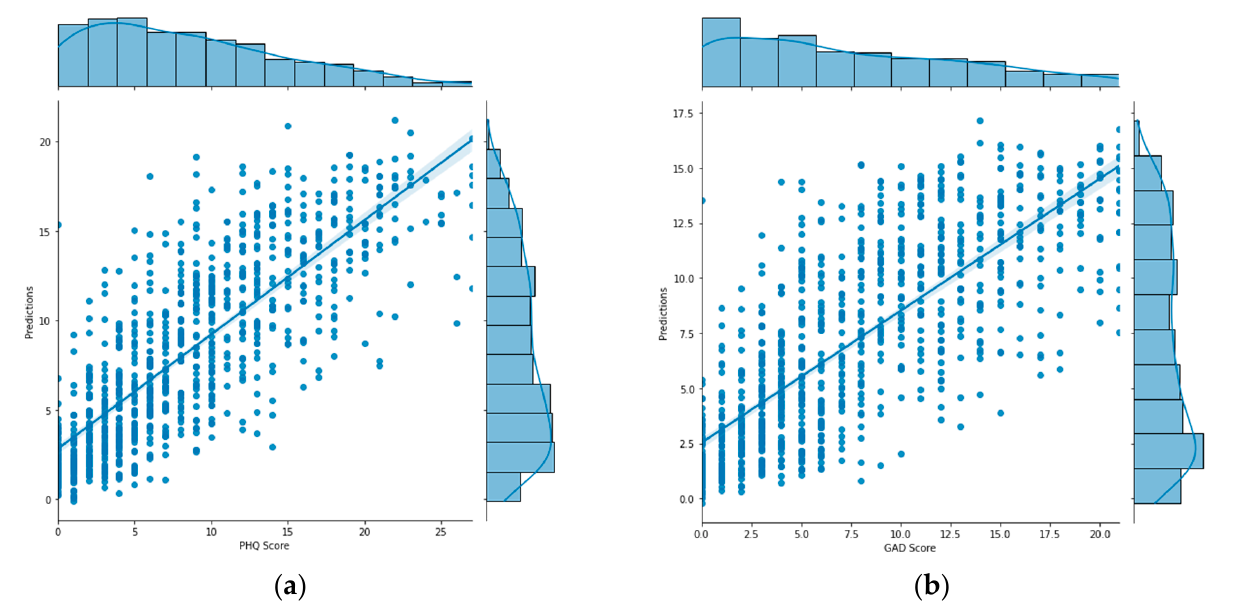
Figure 6. Graph of ( a ) PHQ-V predictions and ( b ) GAD-V predictions (right) compared with values calculated from the PHQ-9 and GAD-7 assessments.